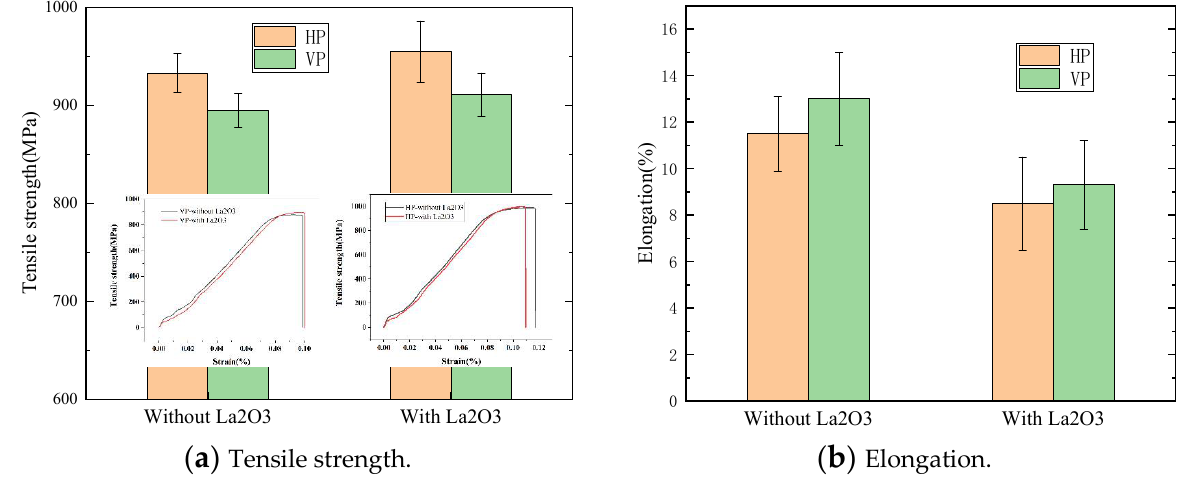
Figure 9. Tensile properties of thin-walled parts. ( a ) Tensile strength of thin-walled parts and ( b ) Elongation of thin-walled